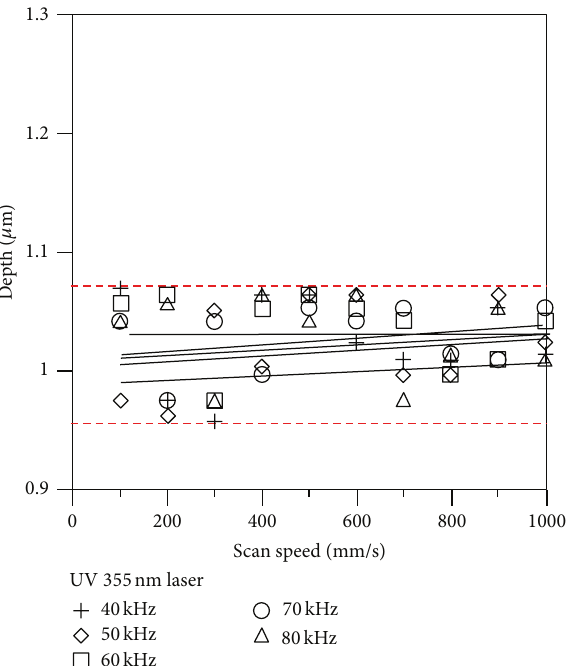
Figure 8: Relationship diagram of UV laser scanning velocities and underline